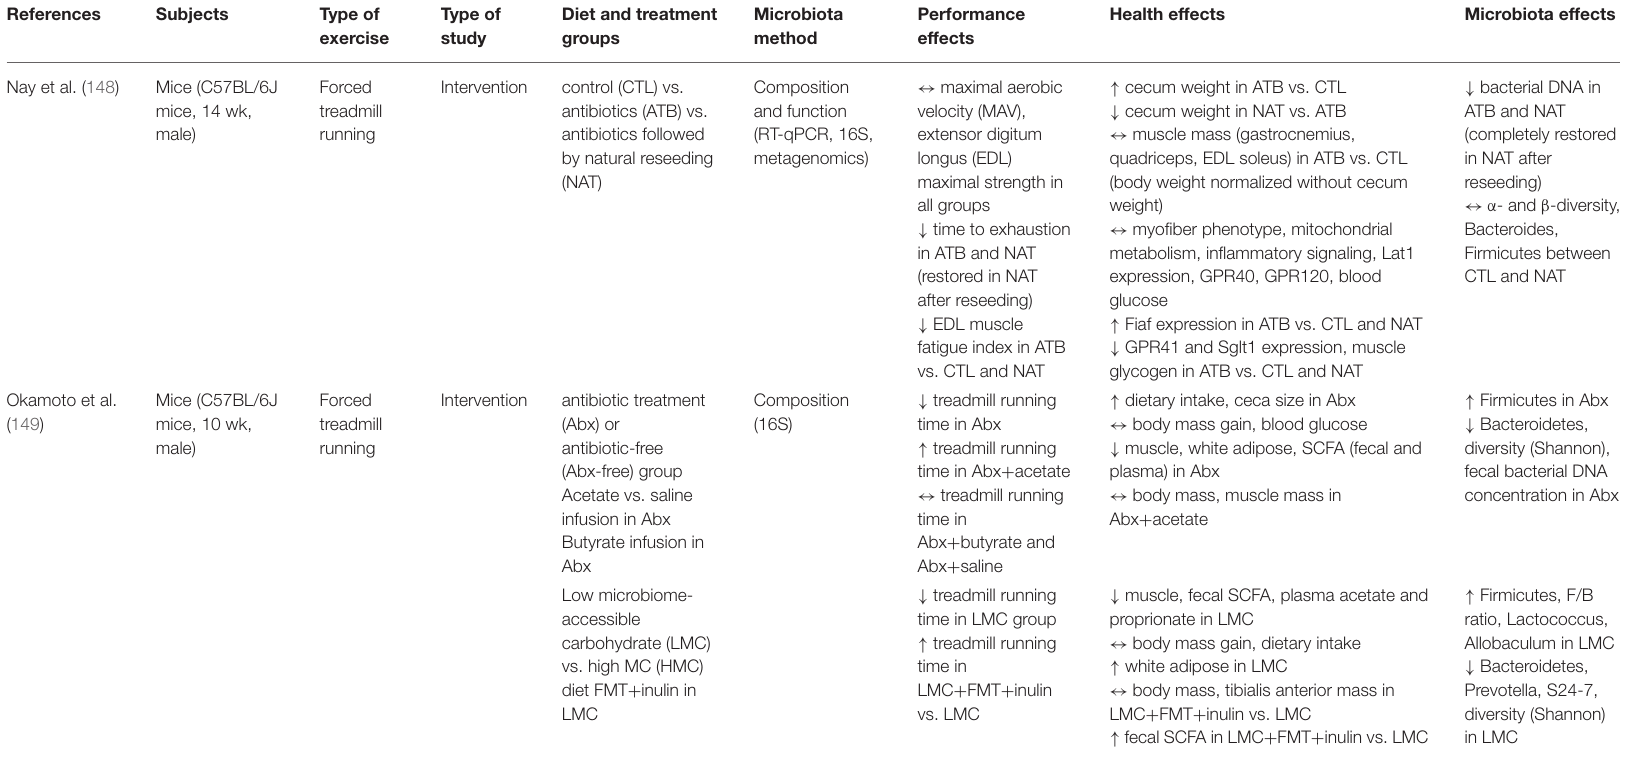
TABLE 5 | Summary of studies investigating the effect of antibiotics on exercise